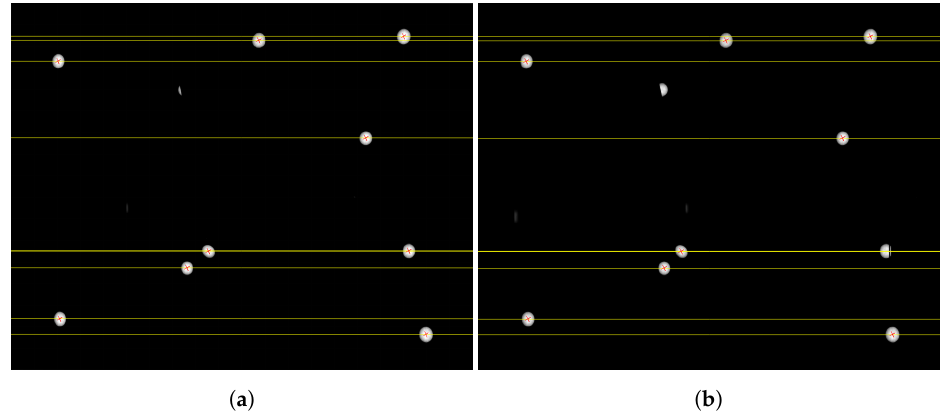
Figure 4. Epipolar lines (yellow) in the left ( a ) and right ( b ) rectified images of the stereo normal case with the found image point correspondences